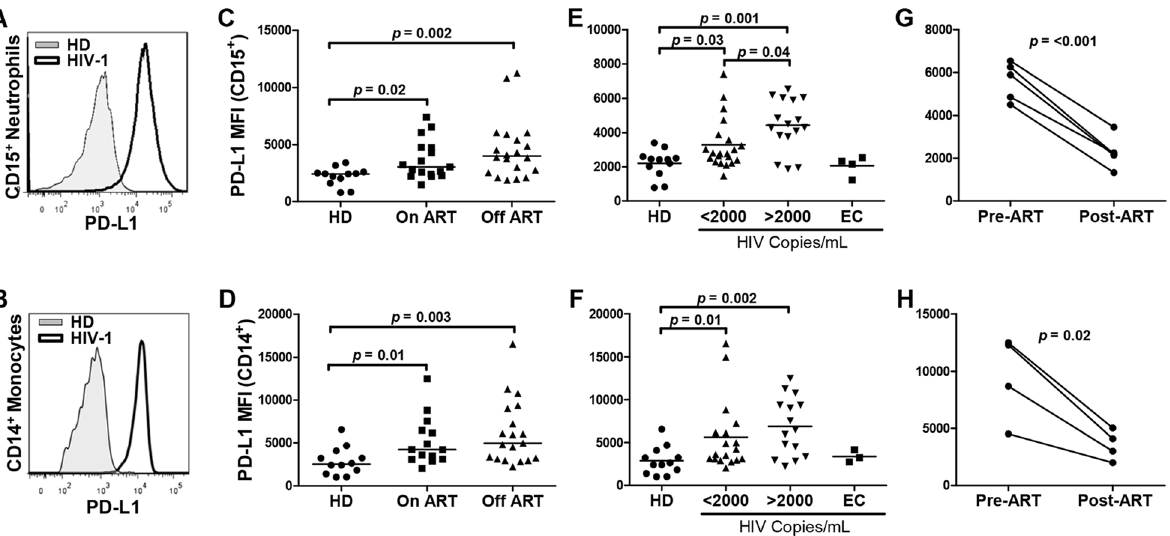
Figure 1. Neutrophils from HIV-1 infected individuals express elevated levels of surface PD-L1. A, B) Representative histogram of PD-L1 expression on CD15 + neutrophils (A) and CD14 + monocytes (B) in fresh blood obtained from a healthy donor (HD) and HIV-1-infected individual. C, D) PD-L1 expression on CD15 + neutrophils (C) and CD14 + monocytes (D) of HDs (N=12), HIV-1-infected patients on ART (N=17), and subjects not treated with ART (off ART; N=20). MFI, mean fluorescent intensity. E, F) PD-L1 expression on CD15 + neutrophils (E) and CD14 + monocytes (F) of HD (N=12) and HIV-1-infected individuals with viral loads , 2,000 vRNA copies/ml of plasma (N=21), . 2,000 vRNA copies/ml of plasma(N=19), or elite controllers (EC: , 50 copies/ml; off ART; N=4). Statistical analysis on C-F was performed using the Mann Whitney rank sum test. G, H) PD-L1 expression on CD15 + neutrophils (G) (N=5) and CD14 + monocytes (H) (N=4) of HIV-1-infected individuals prior to and following the administration of